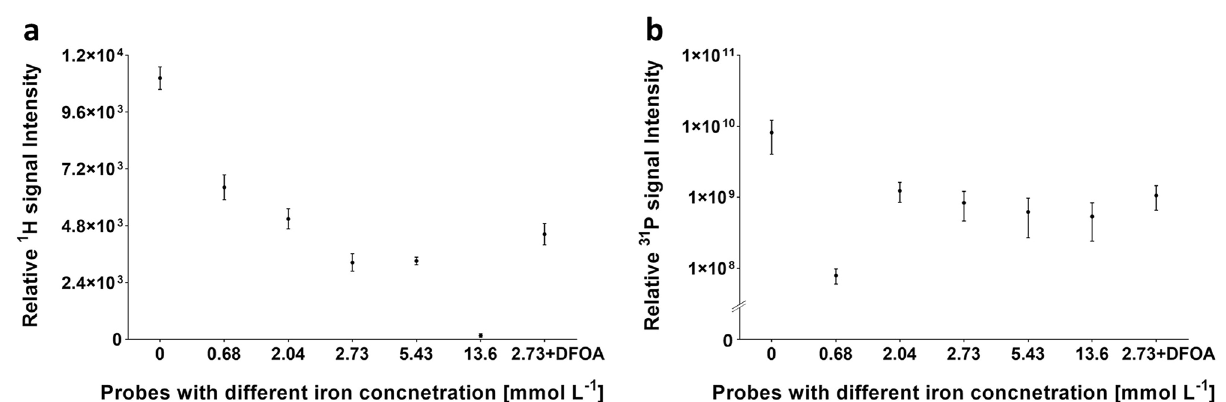
Figure 3. Relative ( a ) 1 H-MRI and ( b ) 31 P-MRI signal intensity (SI) dependence of calcium phytate probes doped with different iron concentrations ( c Fe = 0–13.6 mmol L −1 ) measured on a 4.7 T scanner. Error bars represent standard deviation of mean signal